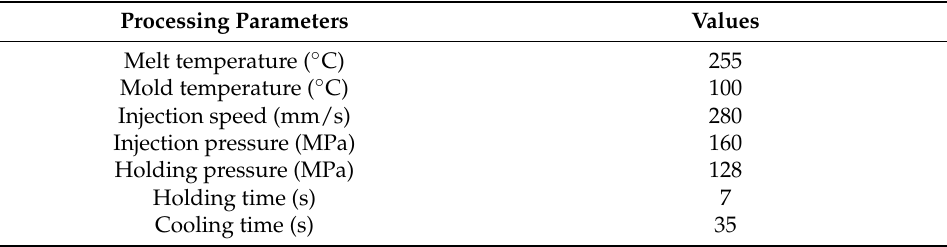
Table 2. The molding process